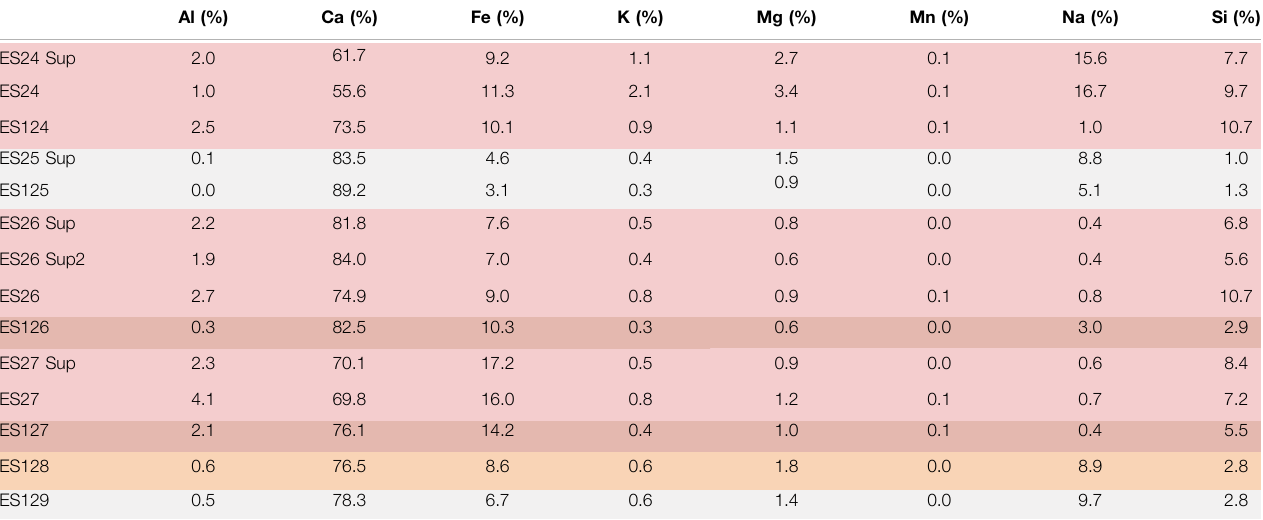
“ Sup ” indicates supernatant extraction rather than bulk extraction. Raw data are included as Supplementary Table S1 .